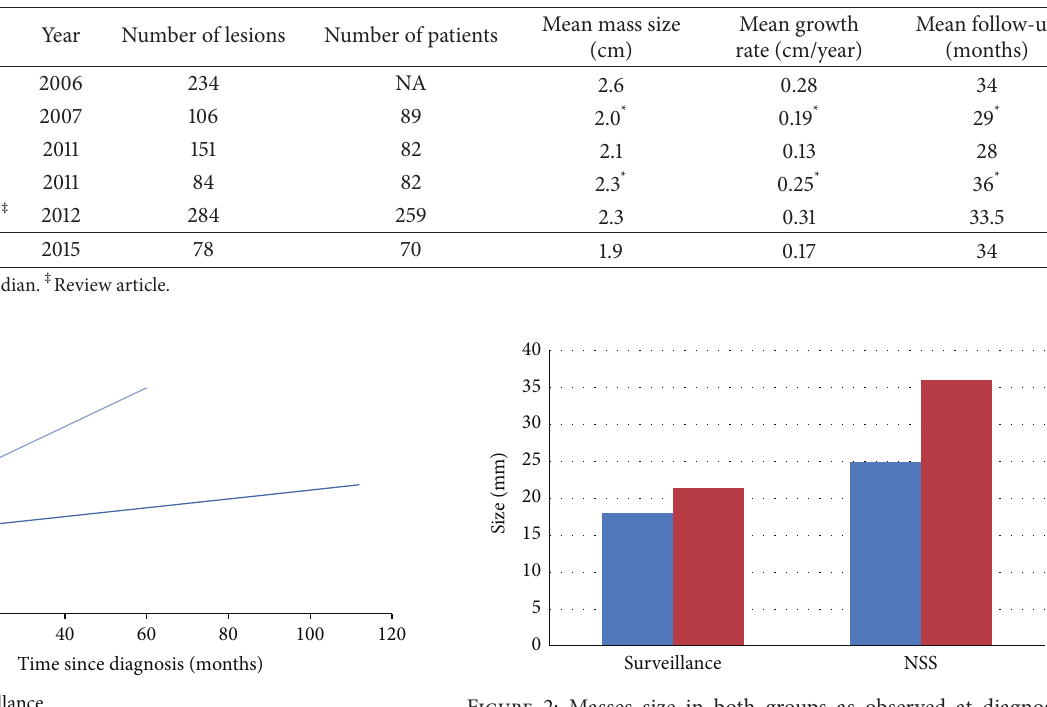
Table 3: Growth rate of SRMs as seen in several studies.